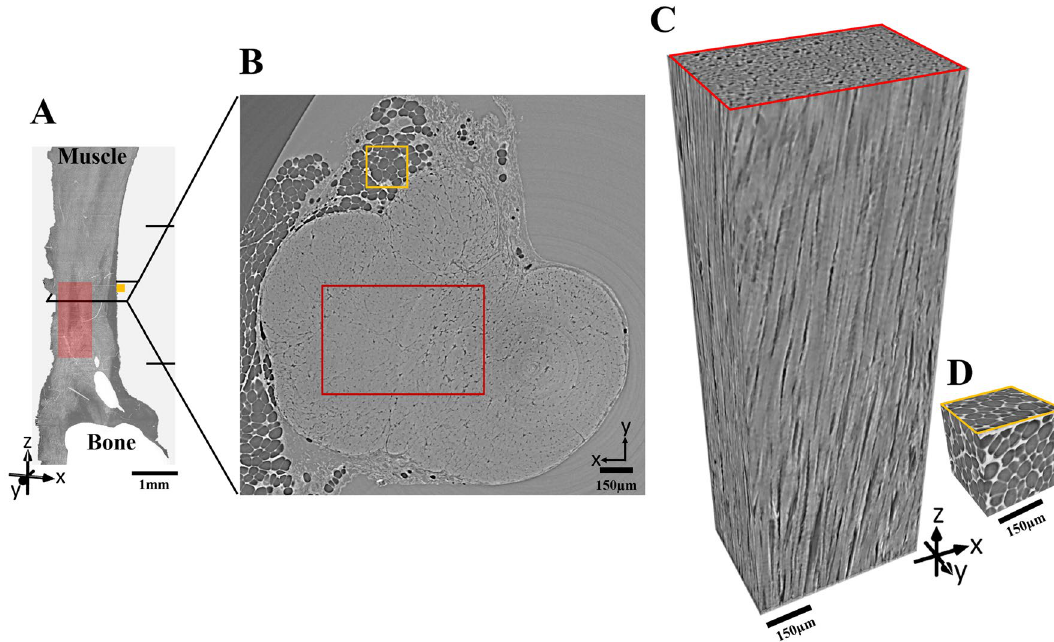
Figure 2. The regions of interest selected for the analysis of image quality. ( A ) volume rendering of the entire imaged tendon after reorientation and stitching of three consecutive the image stacks using the HNAM setup (the field of view of each scan is indicated by the black horizontal lines on the right side); ( B ) cross section of the tendon in the central region indicated in ( A ) by the black rectangle. The red and yellow squares in ( A ) and ( B ) indicate the regions chosen for analysis. ( C ) Volume rendering of the region highlighted in red showing the fiber organization; ( D ) volume rendering of the region highlighted in yellow showing the 3D arrangement of the fat cells that surround the